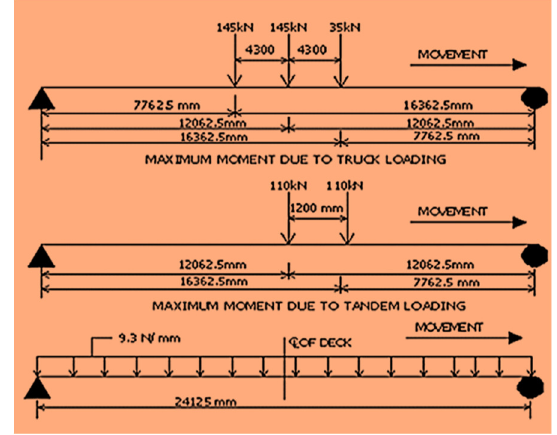
FIG. 5: TYPICAL LIVE LOAD PATTERN FOR BOTH BOX AND T BEAM